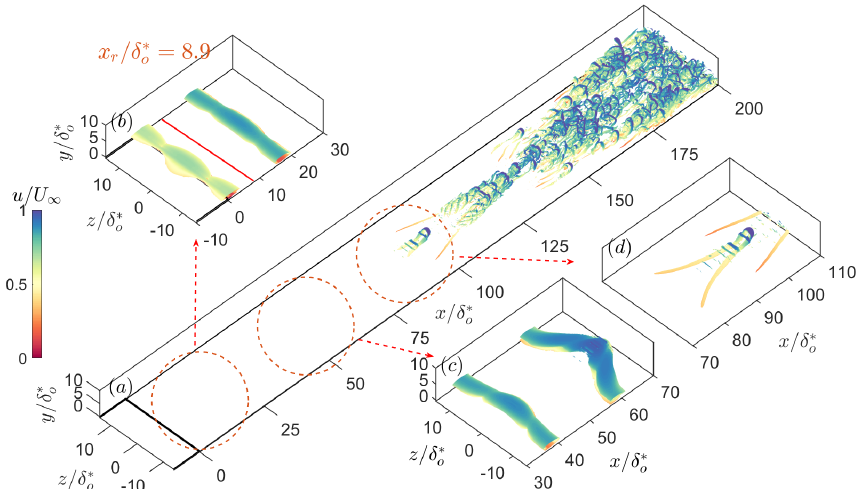
Figure 11. Small step. Isosurfaces of λ 2 , colored by the magnitude of streamwise velocity, u / U ∞ .